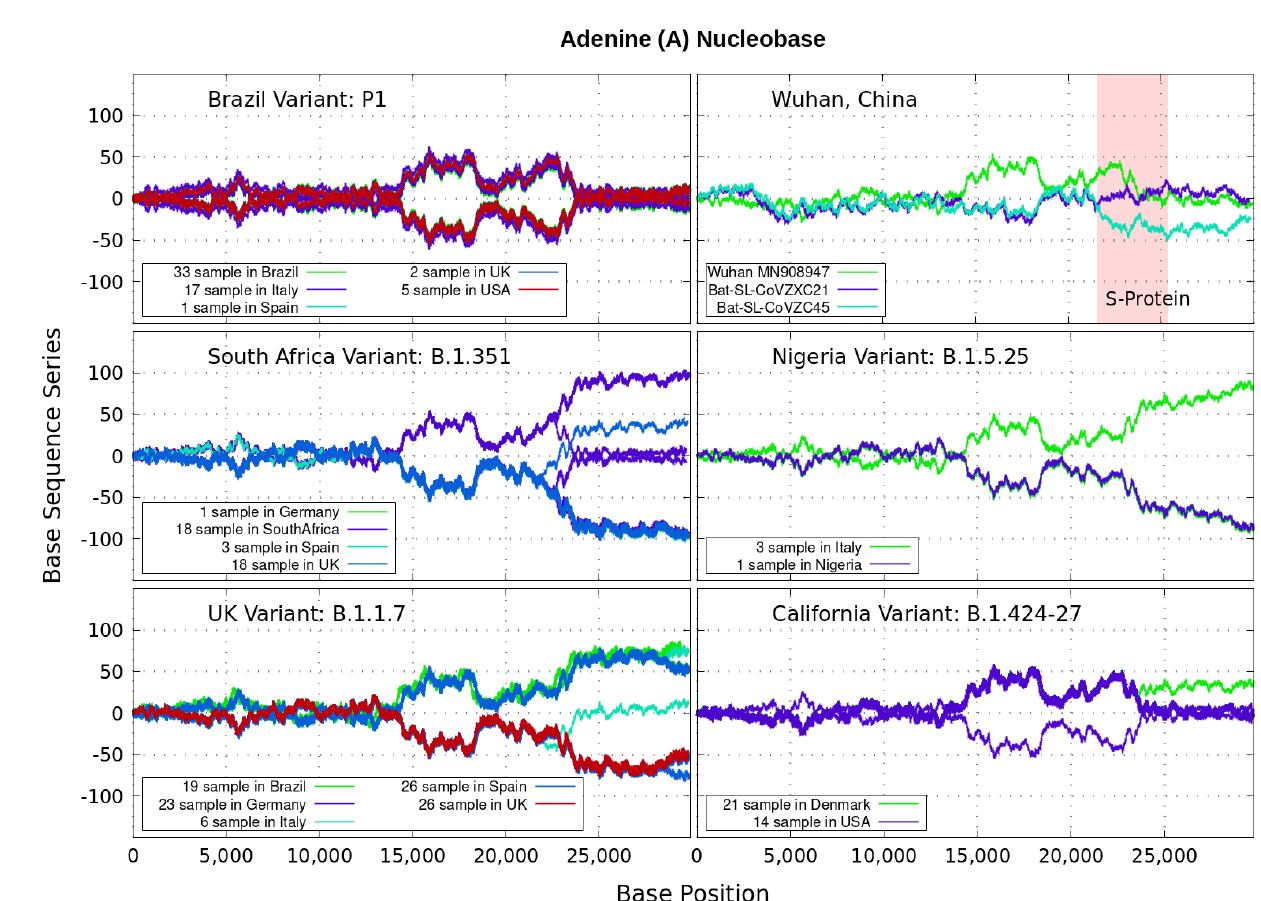
Figure 3. Variant imprints displayed by the nucleotide base: Adenine according to its progression via Equation (1) along different numbers of samples of the genomics strand of coronavirus available from different countries. In red is the genomics region encoding the spike (S-protein). We also illustrate complete genome sequences of SARS-CoV-2 from the city of Wuhan in China and the bat-derived severe acute respiratory syndrome (SARS)-like coronaviruses: bat-SL-CoVZC45 and bat-SL-CoVZXC21 [1]. Note : In all Figures 3–6, the differences in samples shown for a given country correspond to data from a given variant. For example, the difference between the 33 and 19 samples from Brazil means that 33 of the samples correspond with the Brazilian variant P1, and the other different 19 samples are also from Brazil, but they contain the UK variant